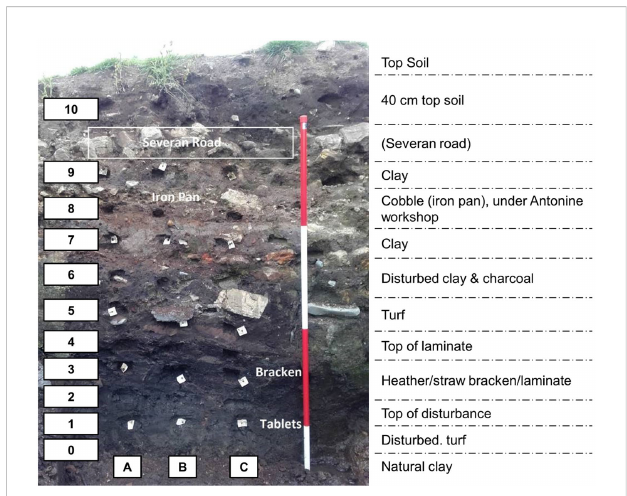
FIGURE 1 Soil sampling strategy and characterized soil